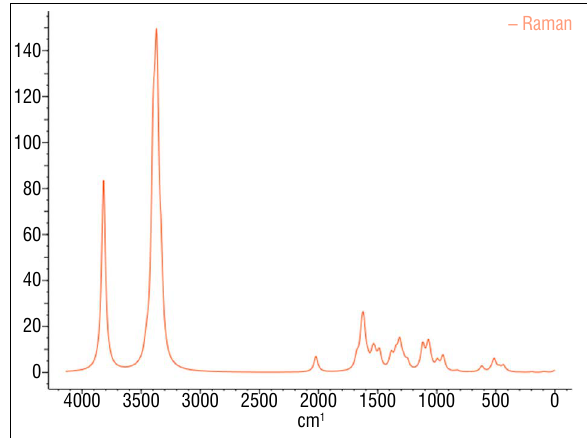
Figure 4: Raman spectrogram of valeraldehyde. NMR prediction